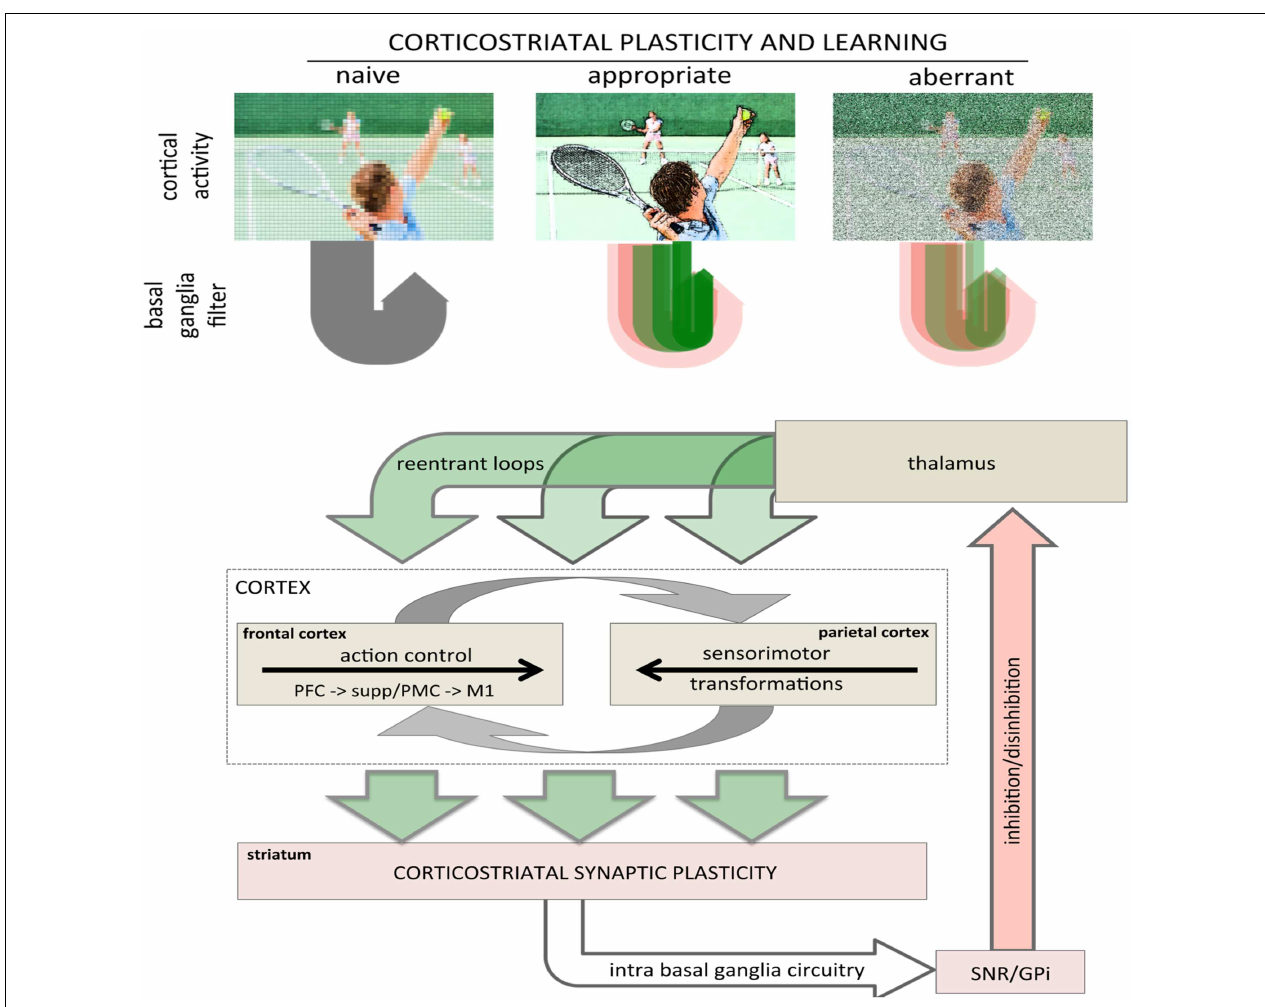
naïve processing (left panel). (bottom) Schematic showing rudimentary architecture for basal ganglia filter of cortical activity highlighting the general loop architecture. Large green arrows represent cortical inputs to the striatum and re-entrant projections returning to the cortex via the thalamus.The intrabasal ganglia circuitry has been collapsed to highlight the basic loop architecture.The cortical schematic has been expanded to represent the two primary intracortical information flows mediating action selection and motor control.The left cortical box represents traditional frontal motor control where information flows rostral to caudal from the prefrontal cortex to M1.The right cortical box represents parietal processing where information flows caudal to rostral mediating sensorimotor transformations specifying movements.These two are intricately interconnected, represented by reciprocal gray arrows. Image used in top panel licensed from Polka Dot